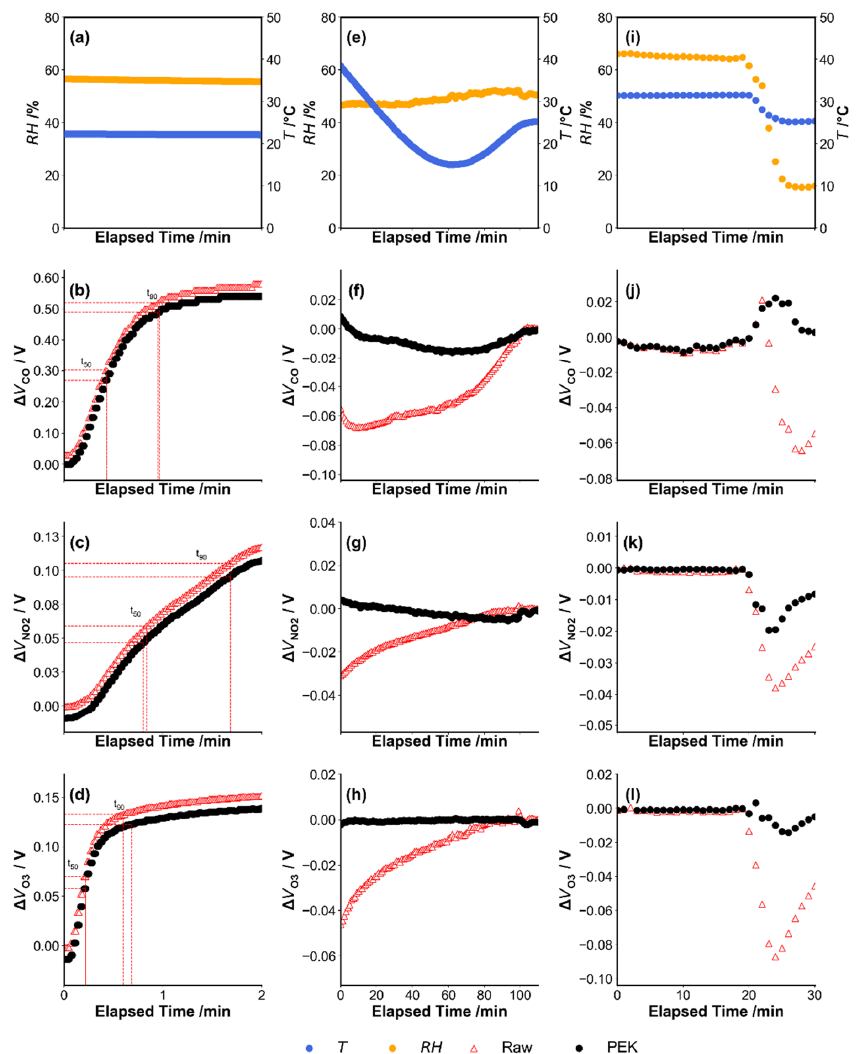
Figure 4. The profile of sensor response after switching the incoming air from zero air to pollutant gas until they reach steady state ( a – d ), and the profile of sensor response after the temperature of the environmental-controlled chamber changed from 40 °C to 15 °C while exposure to zero air ( e – h ), and the profile of sensor response when the zero air in the environmental-controlled chamber with stable climatic condition (T = 30 °C, RH = 65%) experienced a rapid change of relative humidity from 65% to 15% within 7 min ( i – l